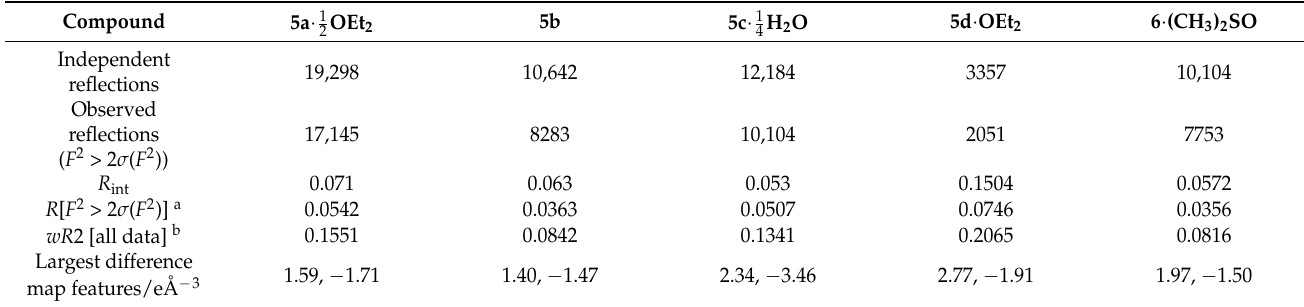
Table 7. Selected bond distances and angles for dichloroplatinum(II) compounds 4b · (CH 3 ) 2 SO , 4c · CHCl 3 , 4d , and 4e · 1 CHCl 3 · 1 CH 3 OH . 2 2